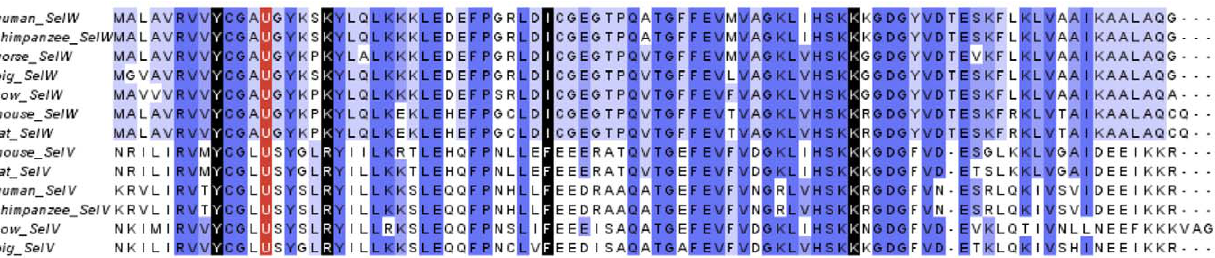
Figure 3. Multiple sequence alignment of SelV and SelW. The last 9 residues of SelV exon 1 and exons 2–5 are shown aligned to complete SelW sequences. The last residue of each exon is marked in black and the Sec in